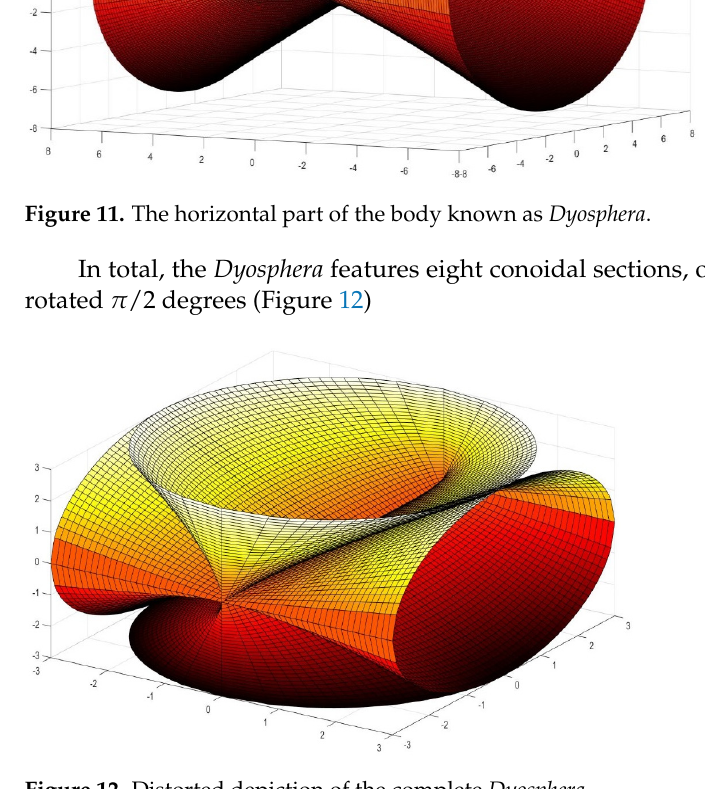
Figure 11. The horizontal part of the body known as Dyosphera.